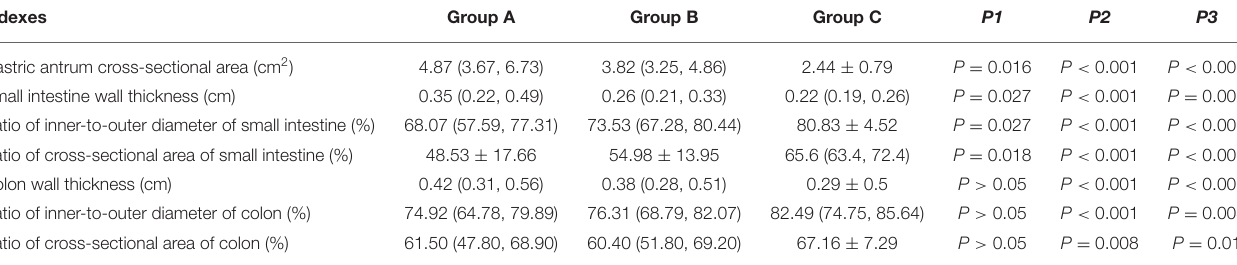
TABLE 2 | Comparison of the gastrointestinal ultrasound data of the three groups.